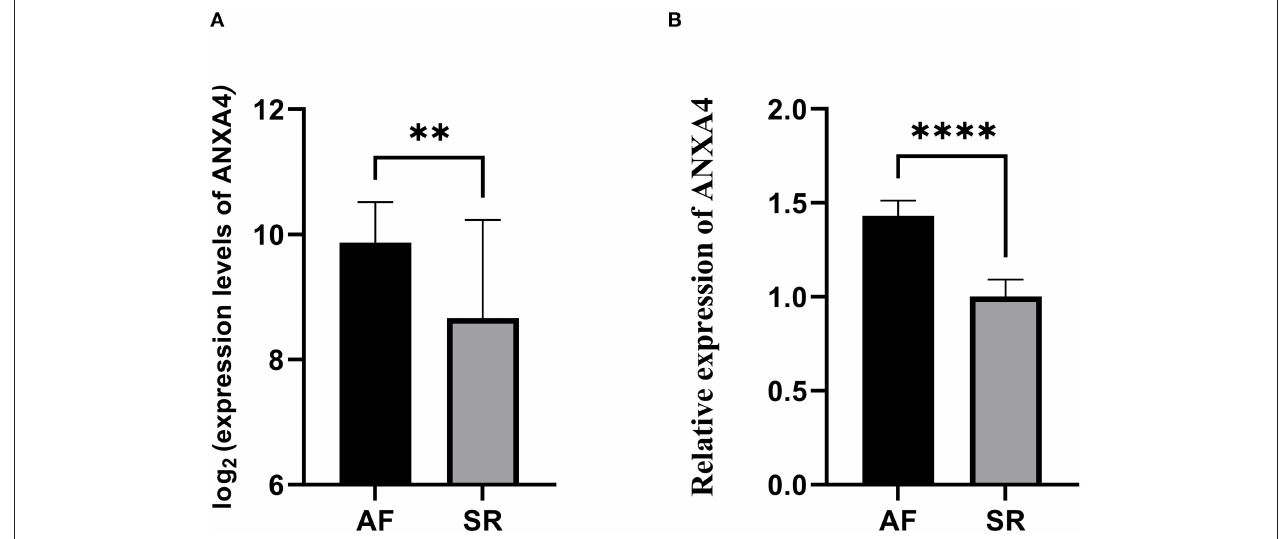
FIGURE 3 | The relative expression of ANXA4 between atrial fibrillation and sinus rhythm. (A) The relative expression of ANXA4 verified by three datasets. (B) The relative expression of ANXA4 in left atrial appendage tissues. ** p < 0.01, **** p < 0.0001.